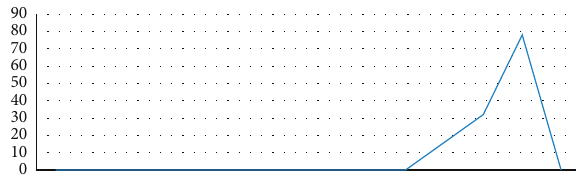
Figure 23: Article distribution by years for systematic map